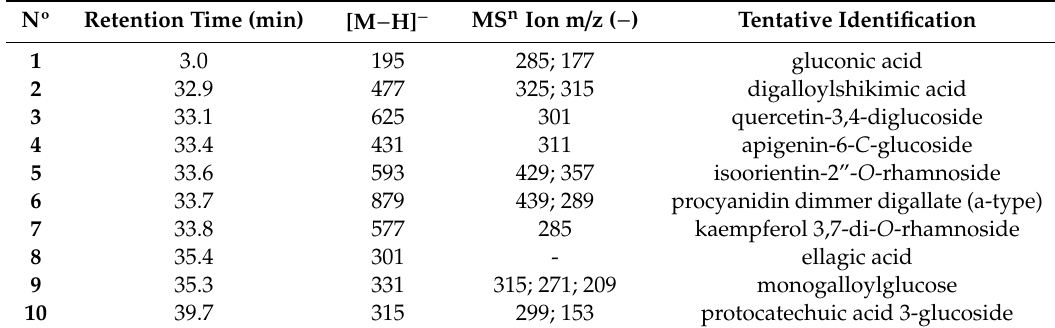
Table 3. Compounds identified by LC-ESI-IT-MS / MS on negative mode, in pollen extract collected by S. a ff . postica.